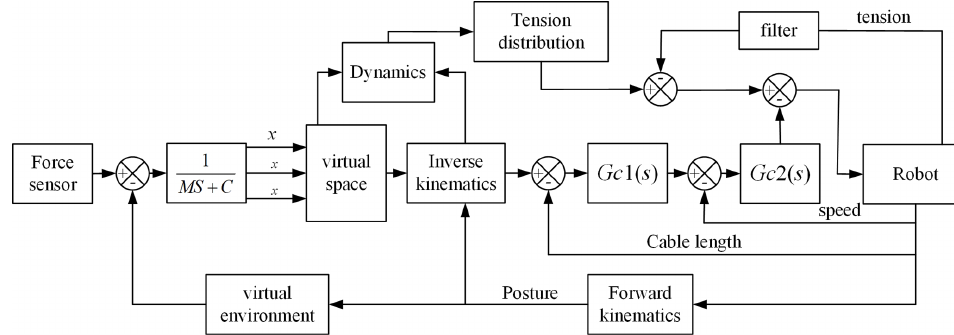
Figure 18. Control strategy of HIR system.